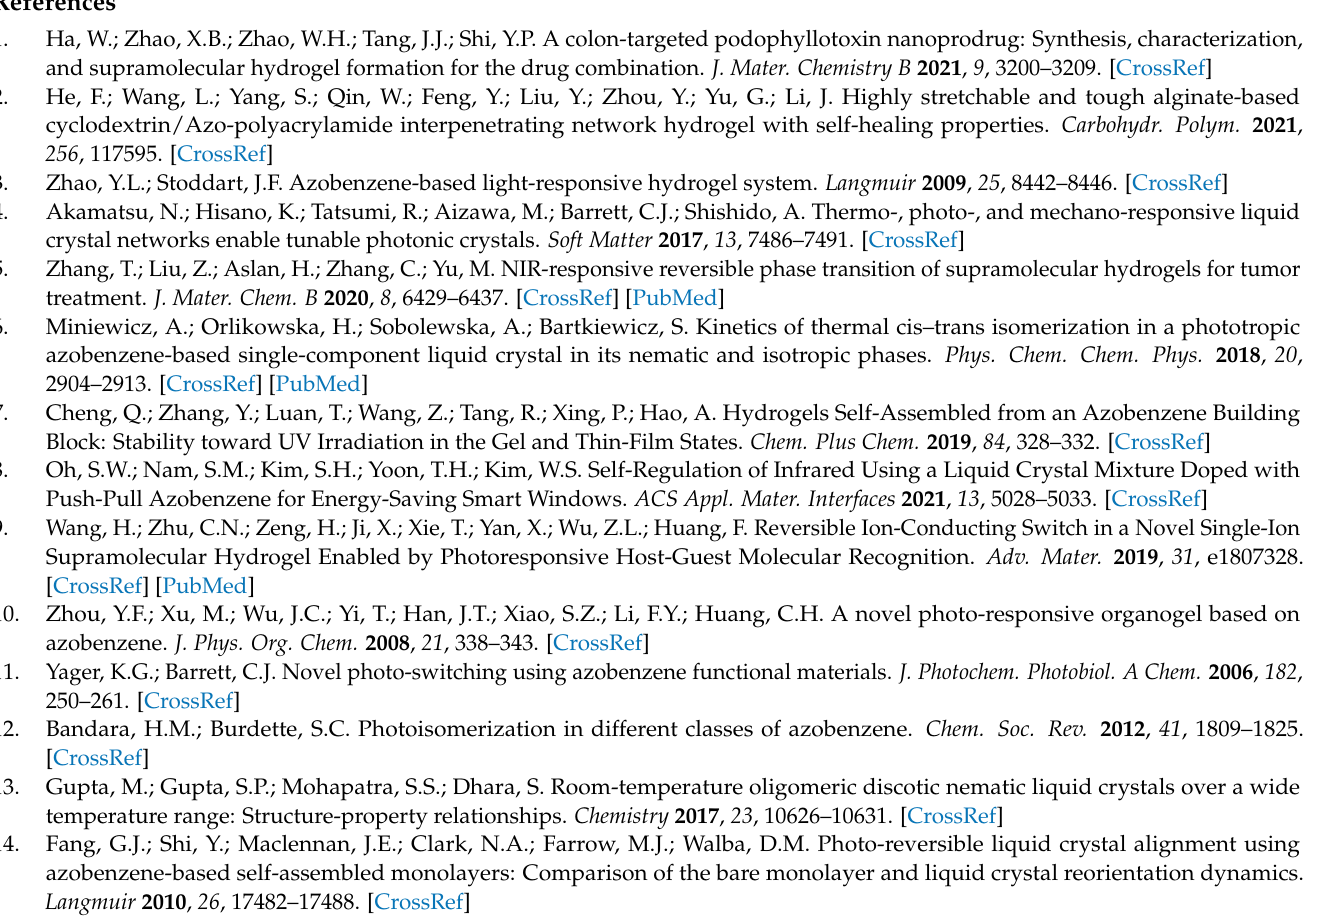
Figure 12. Human fibroblasts L929-supportive properties of the C4-Azo-C5-HDA hydrogels. After hydrogel swelling in culture medium for 24 h, L929 were seeded onto the hydrogels and incubated for 24 h: ( a ) bright field, ( b ) live cells on the hydrogel and ( c ) dead cells on the hydrogel. Supplementary Materials: The following are available online at www.mdpi.com/xxx/s1, Figure S1: 1 H NMR spectrum of compound 1 in CDCl 3 , Figure S2: 1 H NMR spectrum of compound 2 in CDCl 3 , Figure S3: 1 H NMR spectrum of C4-Azo-C5-HDA in CH 3 OH-d 4 , Figure S4: FTIR spectrums of compound 1, compound 2 and C4-Azo-C5-HDA.